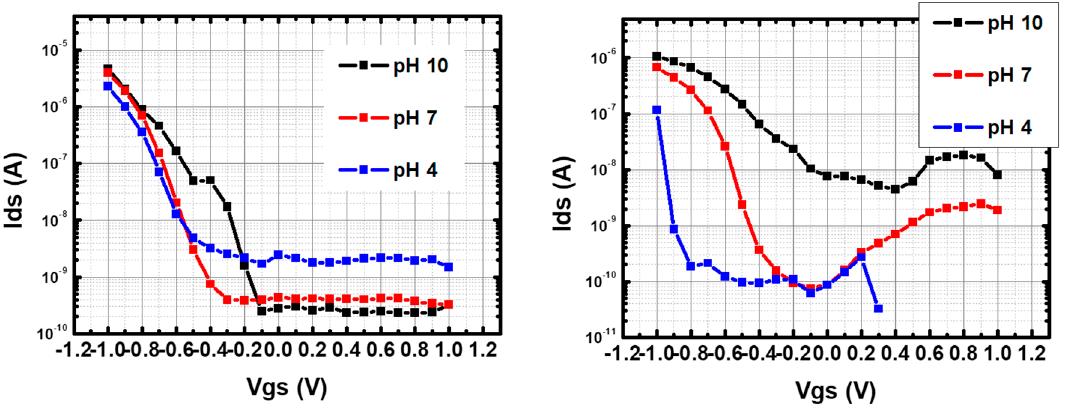
Figure 10. I–V transfer curve of ( left ) p-CNTFETs and ( right ) f-CNTFETs in PBS with respect to Nanomaterials 2023 , 13 , x FOR PEER REVIEW